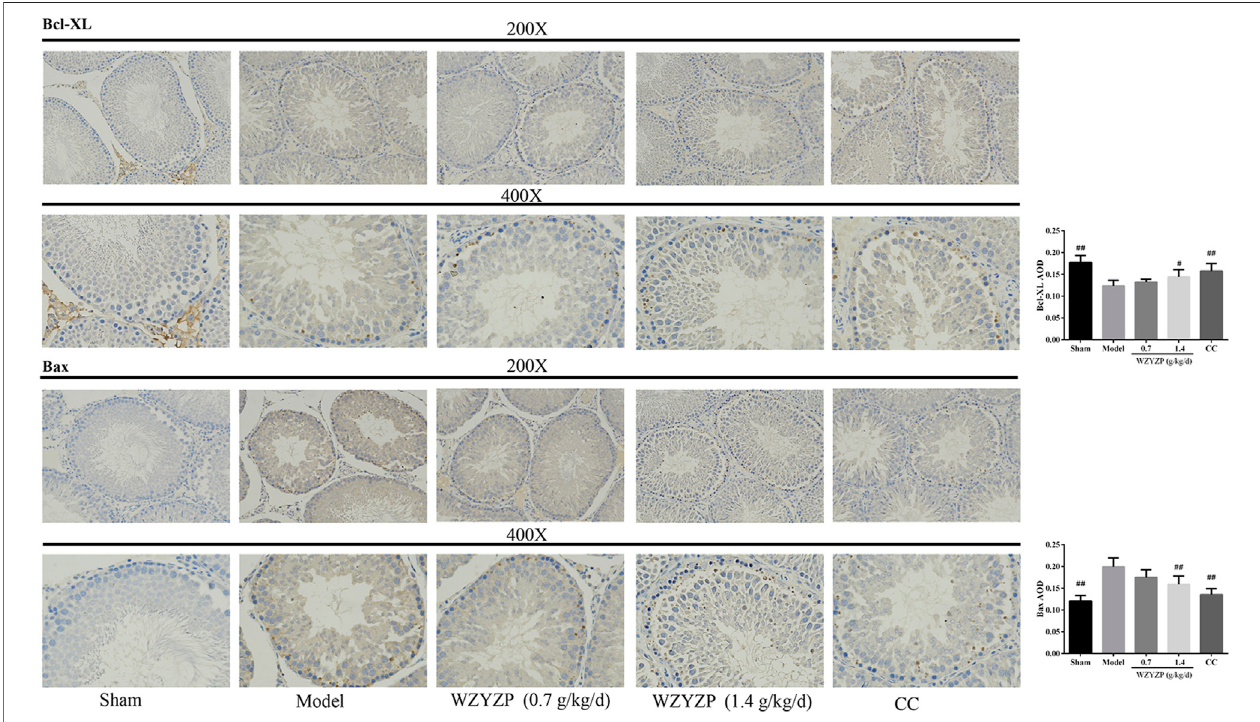
FIGURE6| EffectoftheWZYZPontheexpressionlevelsofBcl-XLandBaxintestestissues.TheexpressionlevelsofBcl-XLandBaxinthetestesweredetermined by immunohistochemistry analysis. Above, magni fi cation × 200, 400. # p < .05 vs. Model group, ## p < .01 vs. Model group.